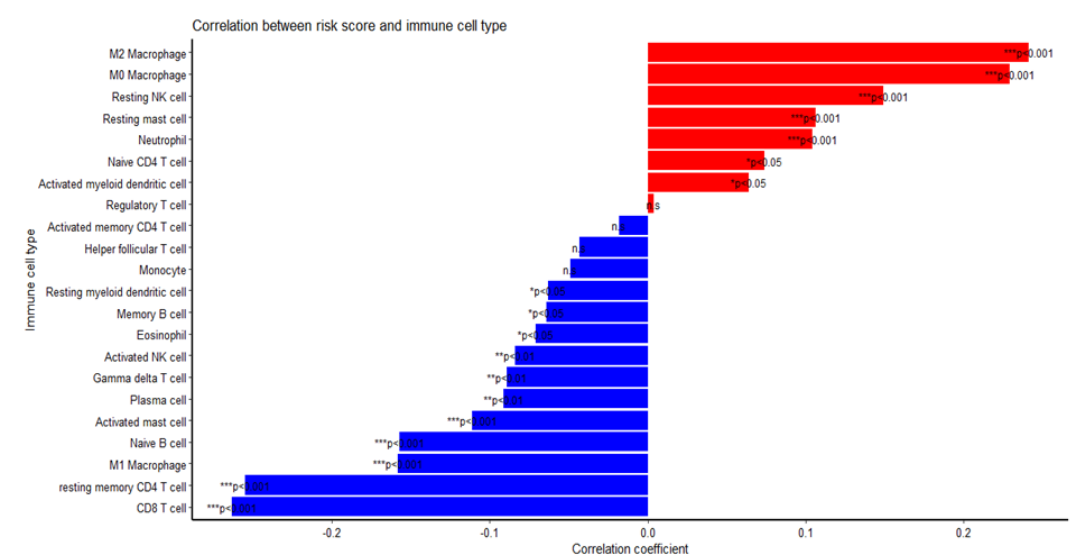
Figure 7. Correlation between risk score and immune infiltrate populations. M2 macrophages had the highest positive correlation with the risk score, while M1 had the third highest negative correlation, after CD8 T cells and CD4 T cells. * p < 0.05, ** p < 0.01, *** p < 0.001.